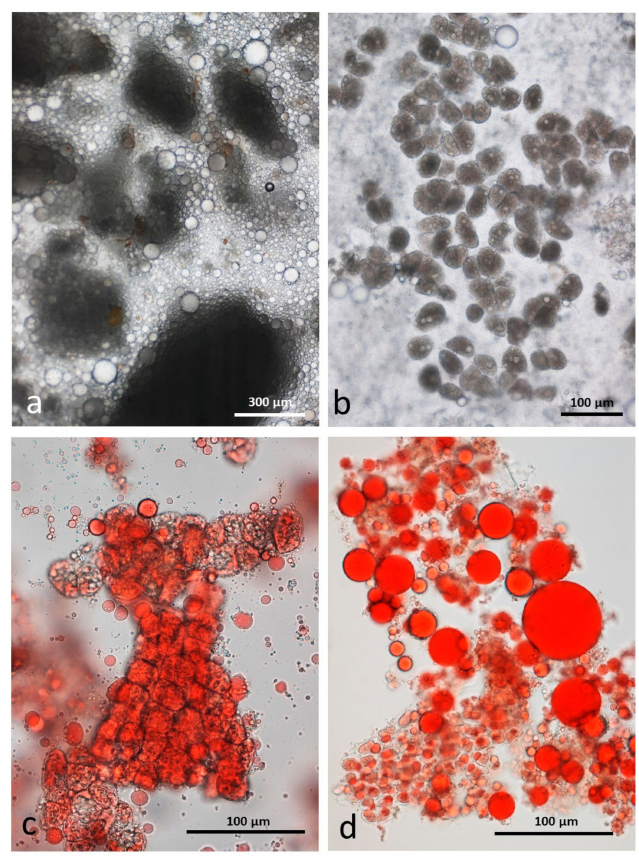
Figure 5. Chewed whole raw almonds stored in CDTA: ( a ) multicellular particles of almond tissue surrounded by released lipid drops; ( b ) individual undamaged cells separated from the larger particles contain lipid still within oleosomes; ( c ) Sudan IV staining showing the even distribution of lipid in oleosomes within whole cells; ( d ) lipid released from damaged cells coalesces into larger drops without